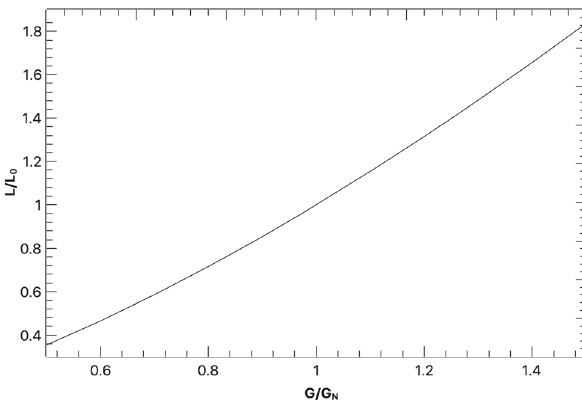
Fig. 1 L / L 0 as a function of G / G N